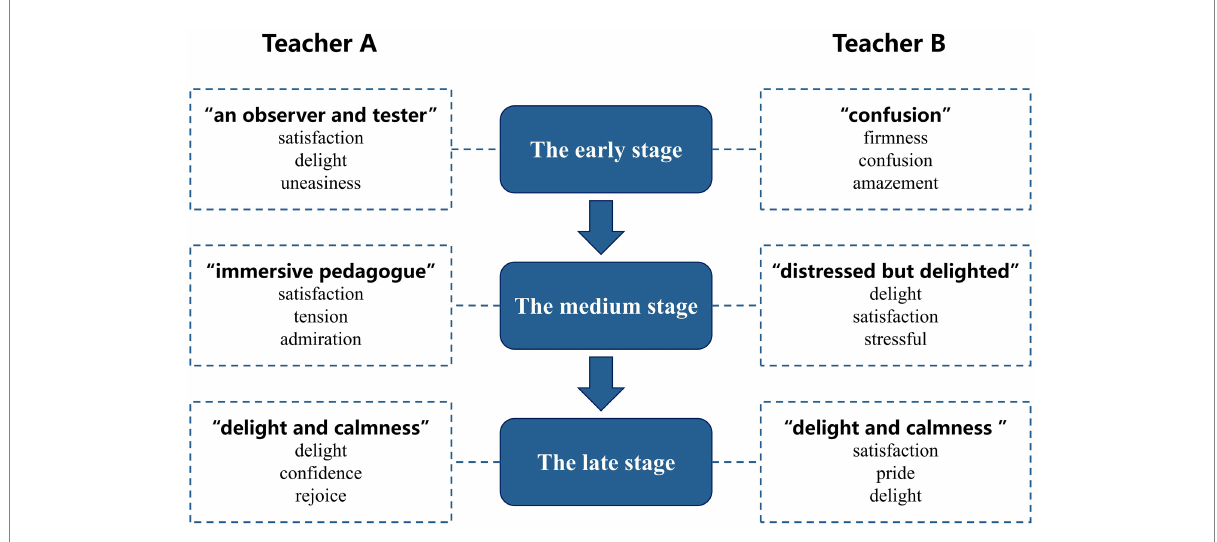
FIGURE 3 A summary graph of emotion changes of two